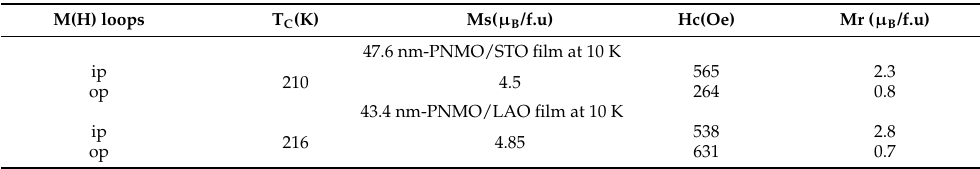
Table 1. Magnetic properties of 47.6-nm-thick PNMO/STO film and 43.4-nm-thick PNMO/LAO film. M(H) loops T C (K) Ms( µ B /f.u) Hc(Oe) Mr ( µ B